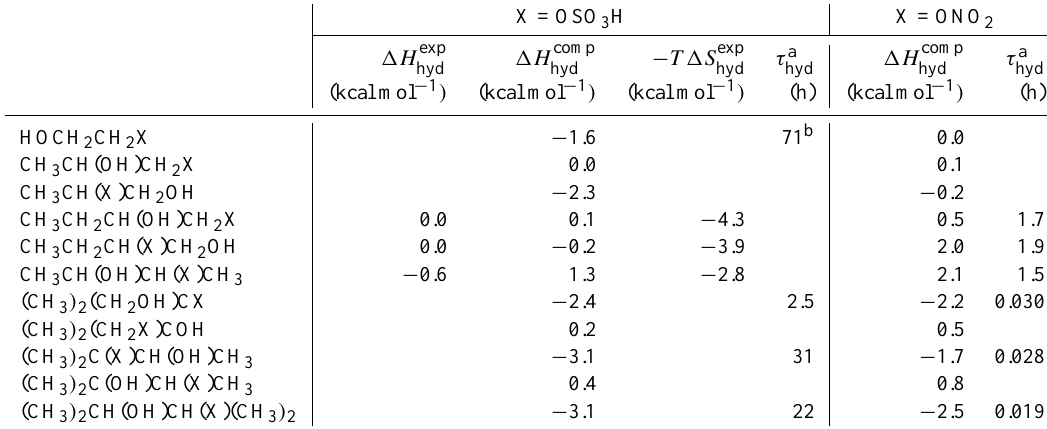
Table 2. Thermodynamic and kinetic parameters for the hydrolysis of difunctional organonitrates and organosulfates.